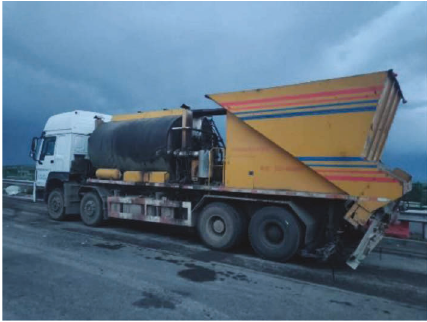
Figure 17: Spreading process of synchronous gravel seal car.